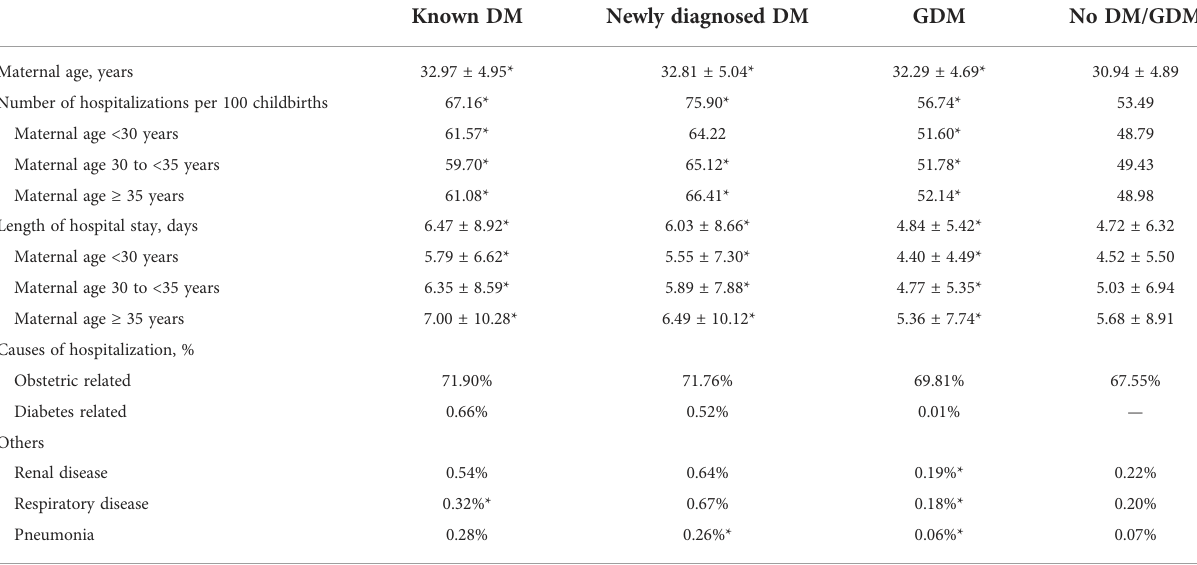
TABLE 2 Number of hospitalizations, length of hospital stay, and causes of hospitalization during the gestation period, 2008-2017.